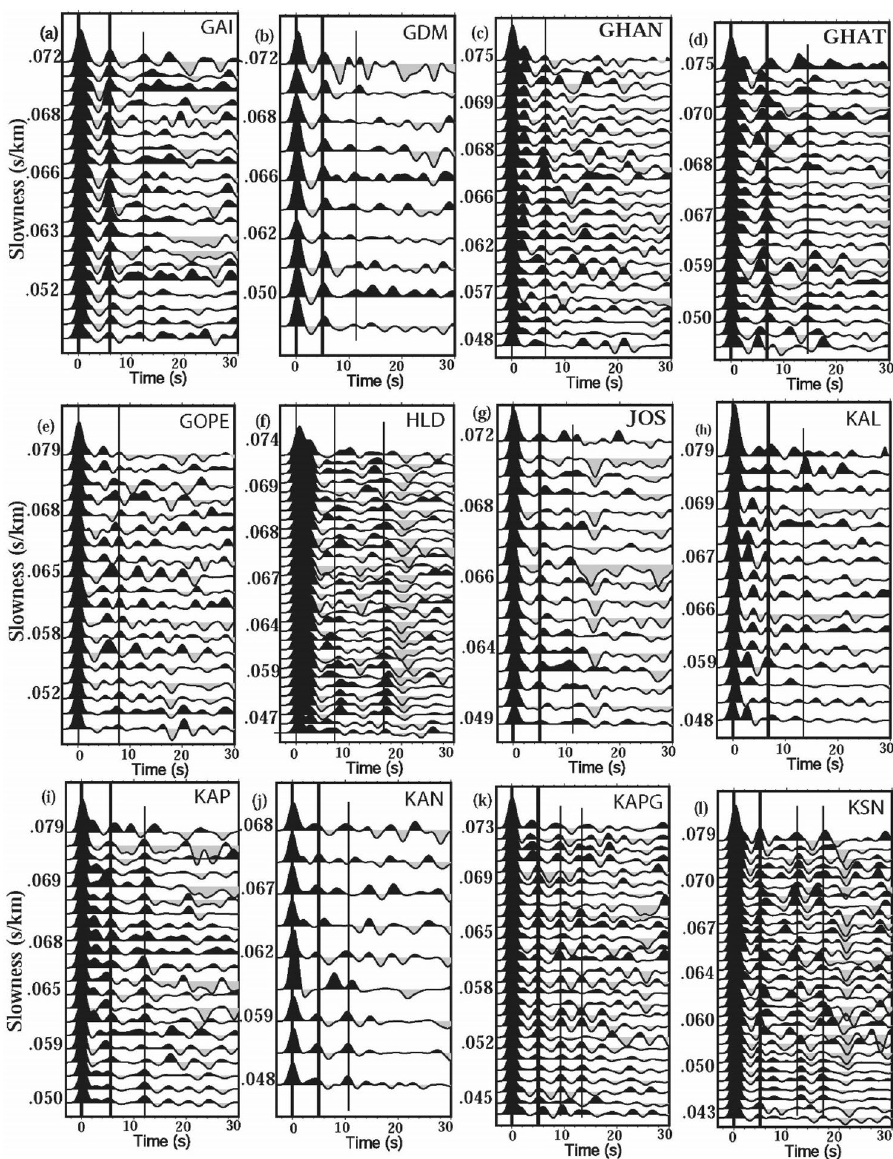
Figure 2. Plots of individual RFs (for a Gaussian width factor, a = 2.0) as a function of the horizontal slowness after distance moveout correction for the Ps phase to a reference distance of 67 ◦ and slowness 6.4 s deg −1 , for 15 broadband sites in the KG Himalaya, ( a ) GAI, ( b ) GDM, ( c ) GHAN, ( d ) GHAT, ( e ) GOPE, ( f ) HLD, ( g ) JOS, ( h ) KAL, ( i ) KAP, ( j ) KAN, ( k ) KAPG, and ( l ) KSN. The PRFs at each station show strong azimuthal variation. The arrivals of direct P and conversions from the Moho (P ms ) and crustal multiples (i.e. PpPs and PpPs + PpSs) are marked by solid black lines. However, for some stations, where the arrival of PpPs + PpSs crustal multiple is weak, are not marked. Here, we have used IASP91 velocity model as the reference model for